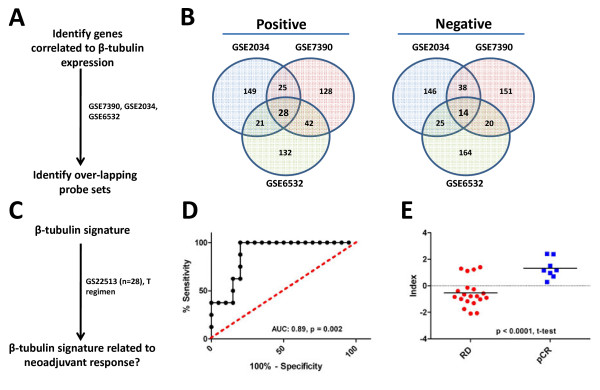
β-tubulin index predicts response to docetaxel chemotherapy.A) Experimental strategy to identify the β-tubulin index. B) β-tubulin co-expressed probesets within the three discovery cohorts. C) Experimental strategy to validate the β-tubulin index. D) ROC analysis of β-tubulin index scores and response to docetaxel neoadjuvant chemotherapy (AUC: 0.89, p = 0.002). E) β-tubulin index scores in patients that experienced pCR or had RD after neoadjuvant chemotherapy ( p < 0.0001, t-test).